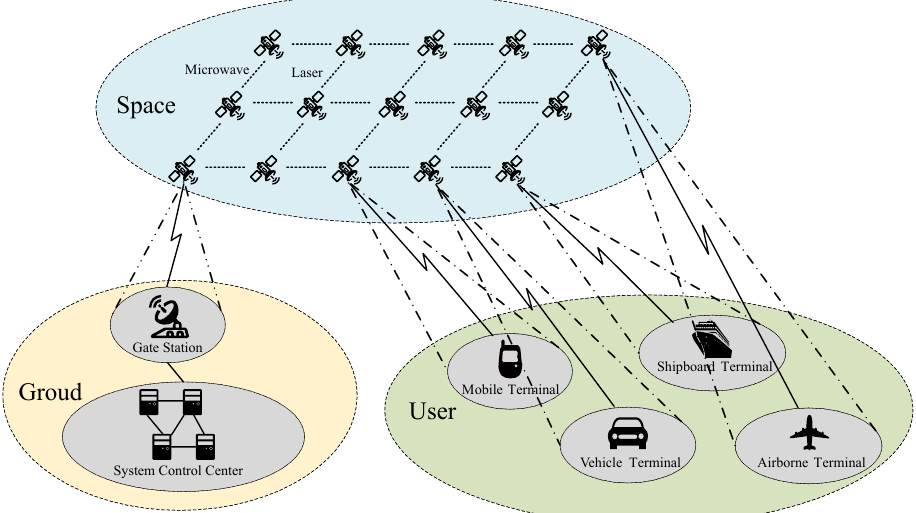
Figure 1. Schematic of an LEO communication satellite